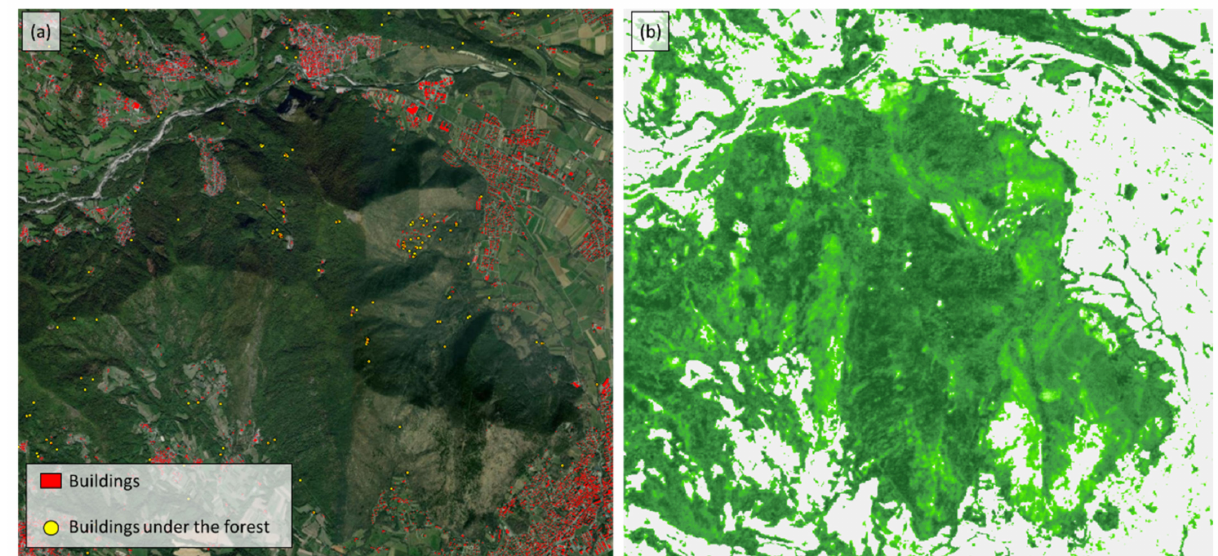
Figure 2. ( a ) In red, the surface of the buildings registered in the cadastre of the Citt à Metropolitana di Torino. In yellow, the centroids of the buildings that are covered by vegetation; ( b ) Tree cover density, dominant leaf type, and forest type products for reference year 2018 in 10 m resolution (High-Resolution